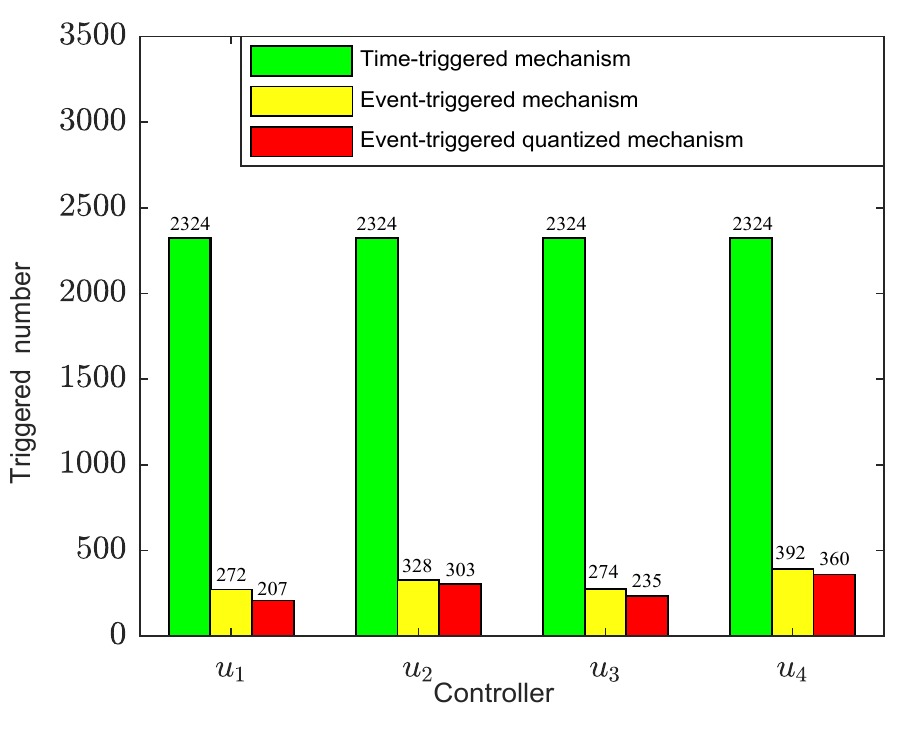
Figure 13. The triggered numbers of different